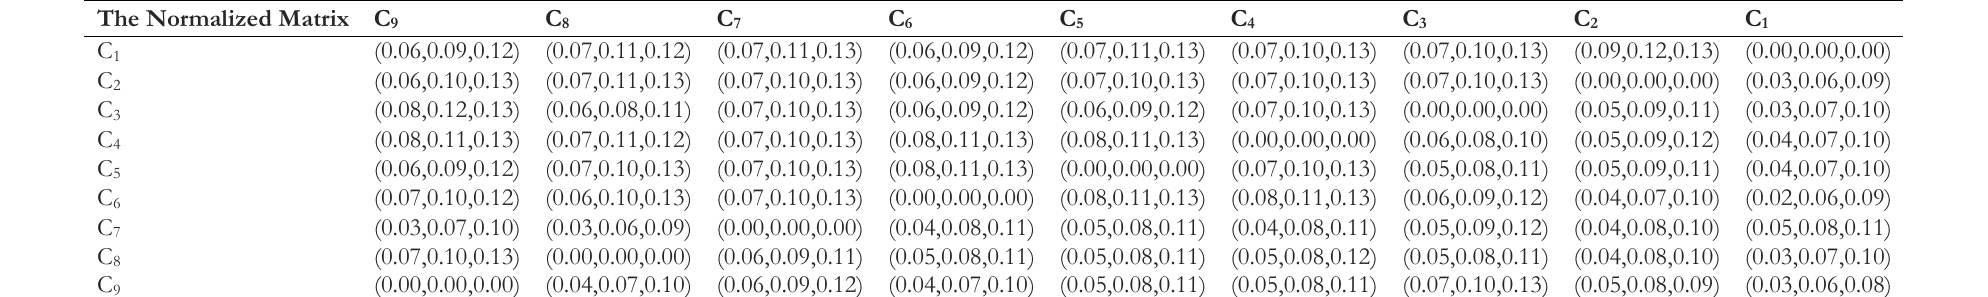
Table 5. The normalized matrix.